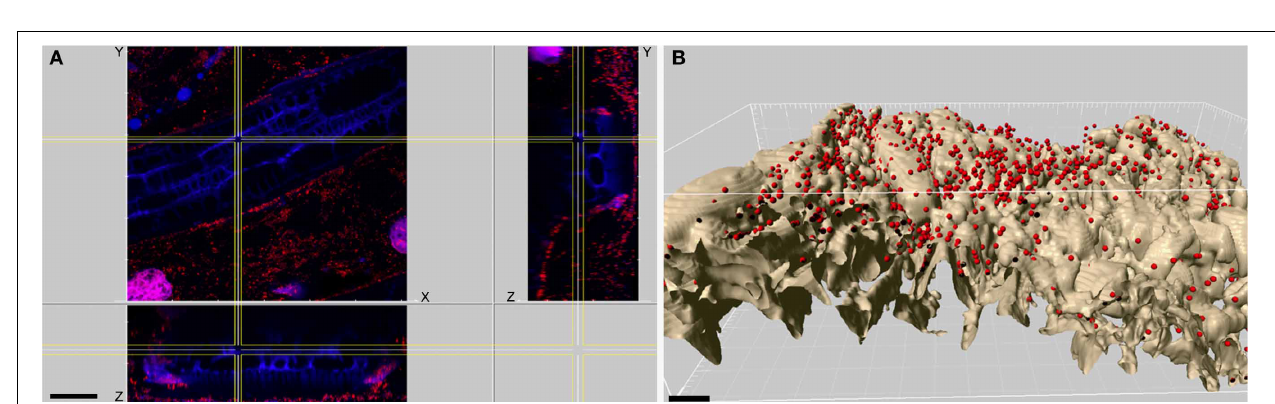
the displayed taxa was restricted to 5. The positions of the points are the averages for the jackknifed replicates generated by QIIME and are shown with ellipses representing the interquartile range (IQR) in each axis. Larger ellipses represent more diverse communities. Colors correspond to the different treatments.